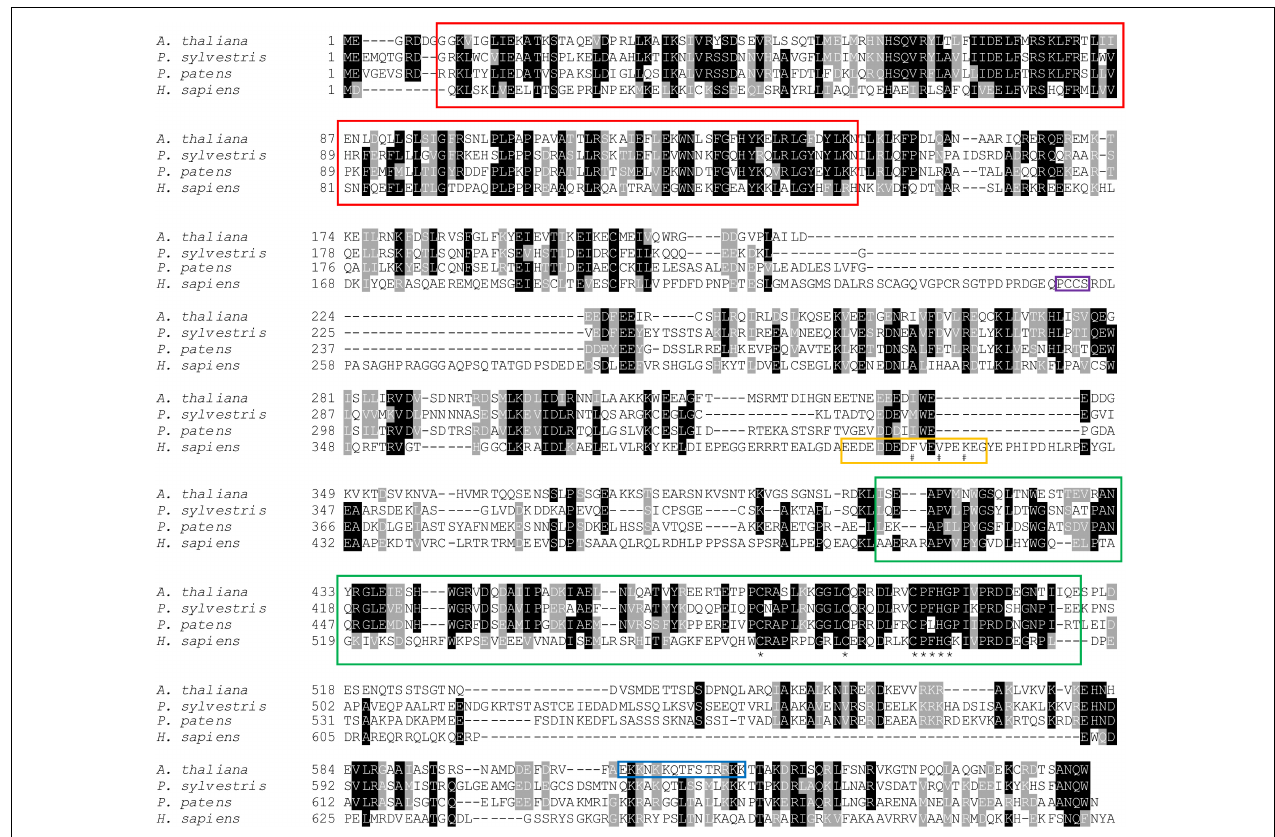
FIGURE 2 | Amino acid alignment of UVSSA from representative angiosperm ( Arabidopsis thaliana ), gymnosperm ( Pinus sylvestris ), moss ( Physcomitrella patens patens ), and animal ( Homo sapiens ) species. Sequences were aligned using NCBI COBALT (Papadopoulos and Agarwala, 2007) and formatted using Boxshade. Amino acids showing identity (black) and similarity (gray) are indicated. Conserved ENTH/VHS (red) and DUF2043 (green) domains are boxed, with asterisks indicating conserved cysteines and CP(y/l)HG motif in the DUF2043 domain (Marchler-Bauer et al., 2017). The blue box indicates potential bipartite NLS in Arabidopsis UVSSA identified using Prosite (De Castro et al., 2006). Regions required for interaction of human UVSSA with USP7 (purple) and TFIIH (yellow) are shown and key residues indicated with #s (Higa et al., 2016, 2018; Okuda et al.,